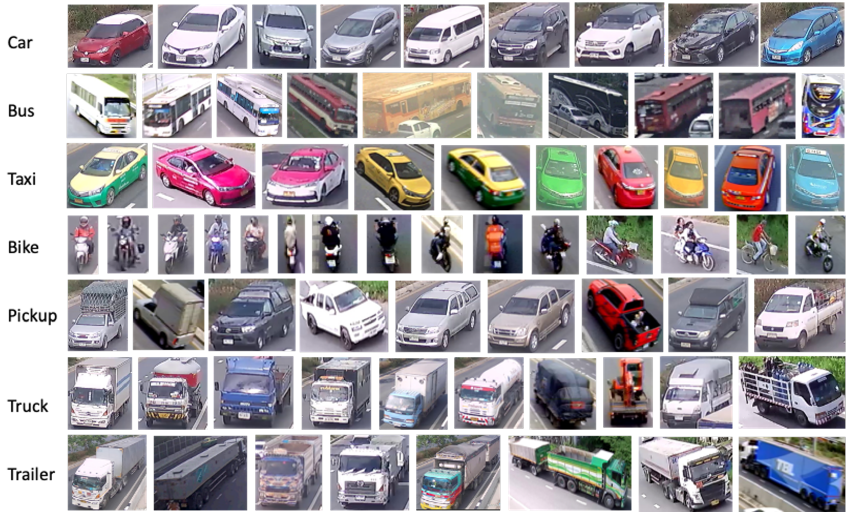
Figure 2. The samples of car, bus, taxi, bike, pickup, truck, and trailer (Classes 0 to